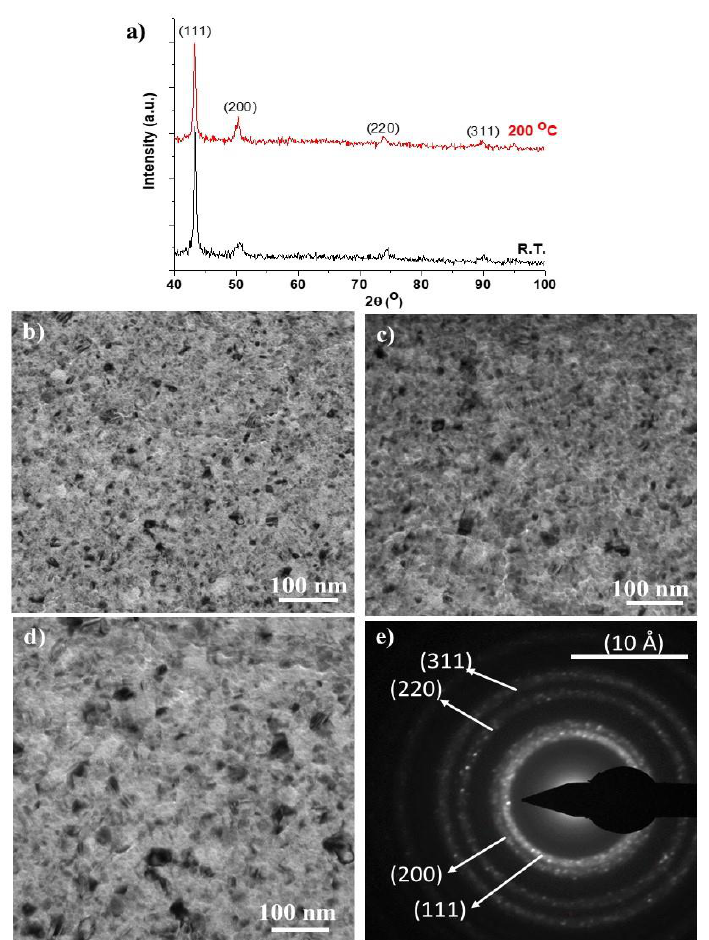
Figure 5. Structural characterization of the Cu thin film: ( a ) X-ray diffractogram, at room temperature and after 24h at 200 °C; ( b ) Transmission electron microscopy (TEM) bright field image of the as-deposited coating; ( c ) TEM bright field image after 2h at 200 °C; ( d ) TEM bright field image after 24h at 200 °C; ( e ) electron diffraction pattern of the area showed in ( a ).